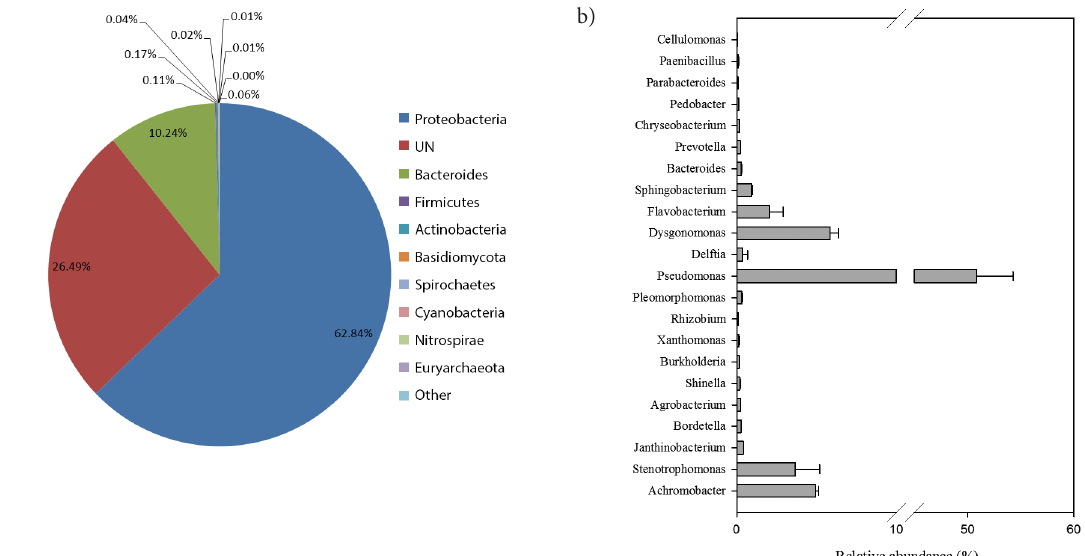
Figure 2. Species distribution for Phylum (a) and Genus (b) of